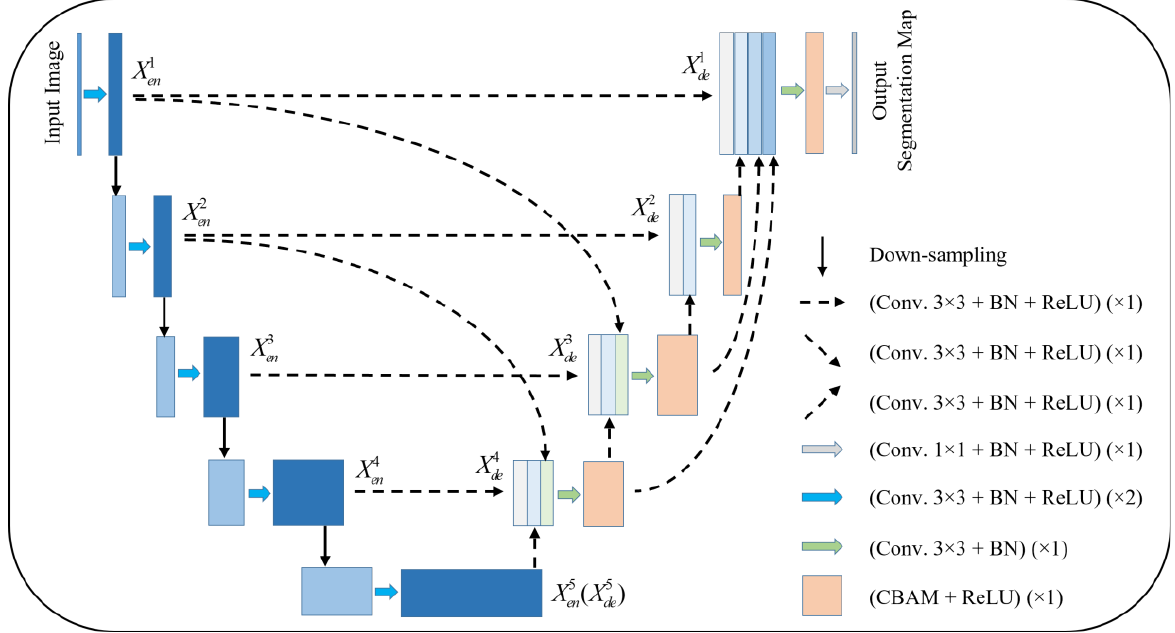
Figure 1. An improved UNet 3+ model combined with CBAM.